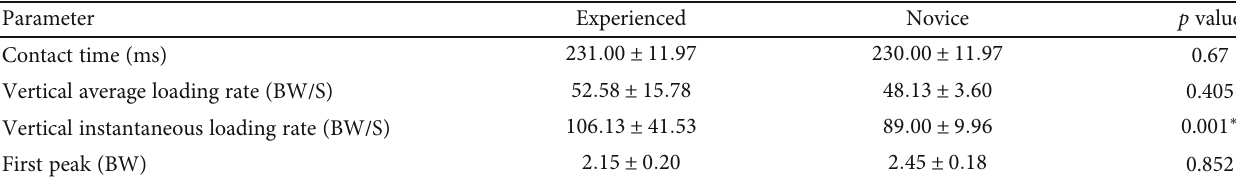
Figure 5: Sagittal ankle, knee, and hip joint power and moment for novice runners (the solid blue line is the mean and the shaded area is the standard deviation) and experienced runners (dashed red line is mean). Note: the dotted box indicates a signi fi cant di ff erence between the two groups of runners, p < 0 : 05 . Table 5: Ground reaction force parameter during the stance phase ( n = 24